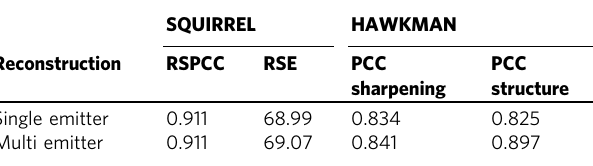
Table 1 Comparison of reconstruction quality metrics for SQUIRREL and HAWKMAN on challenge microtubule